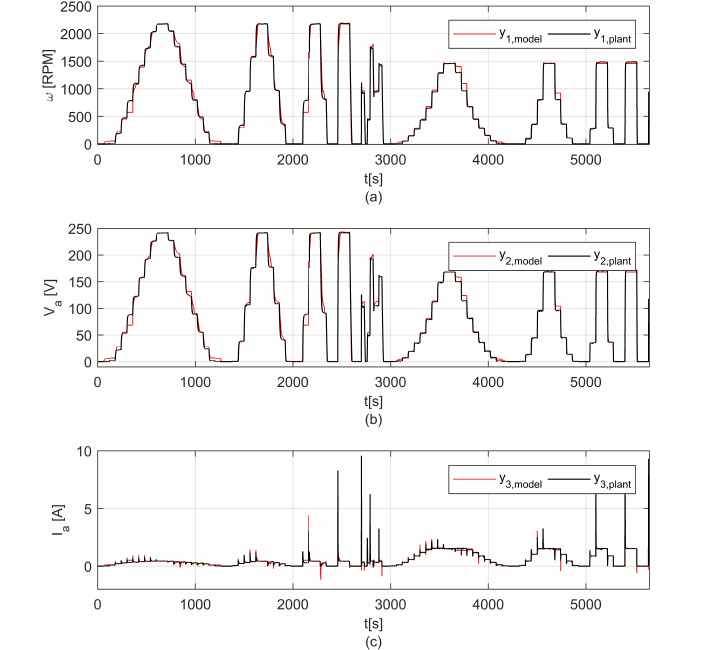
Figure 7. DC motor output signal at model and plant: ( a ) speed, ( b ) armature voltage and ( c ) armature